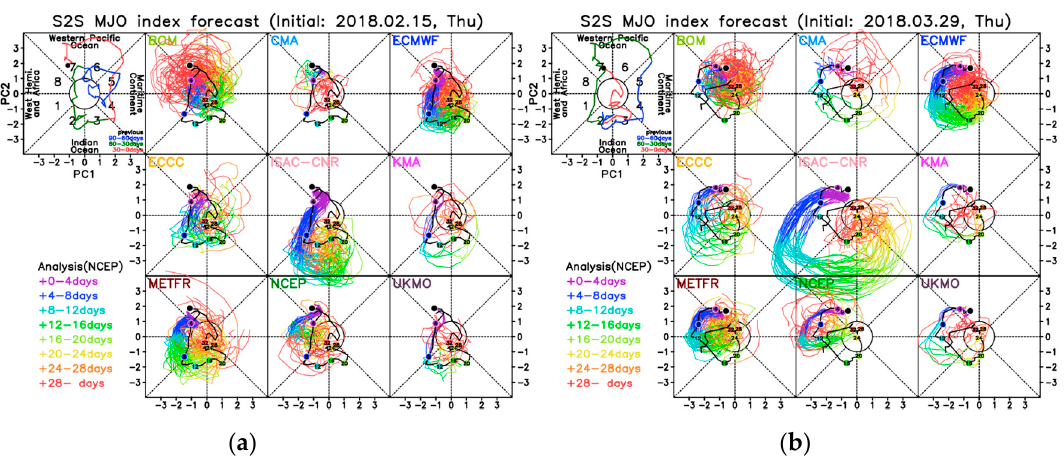
Figure 11. Sub-seasonal forecasts of the MJO. Ensemble forecasts of MJO track from forecasts initialized on ( a ) early 15 February (two to three weeks ahead of MJO activity in early March associated with the P1 rainfall event) and ( b )) 29 March (two to three weeks ahead of MJO activity in mid-April associated with the P3 rainfall event). Sub-panels indicate forecasts from the different centers contributing to the sub-seasonal to seasonal prediction (S2S) project [26]; in each sub-panel, the thick black line indicates observations, whilst the thin lines show ensemble forecast tracks. The colors of forecast tracks and numbered circles on the observed track indicate forecast lead times. The top left sub-panel shows 90 days past conditions. Plots accessed from the S2S museum (http://gpvjma.ccs.hpcc.jp/S2S/; see here for definitions of model acronyms). Similar plots for more start dates are available in the supplementary material. Here, the ECMWF and UKMO refer to the ECMWF extended range system and the UK Met Office GloSea5 prediction system discussed elsewhere in this analysis.